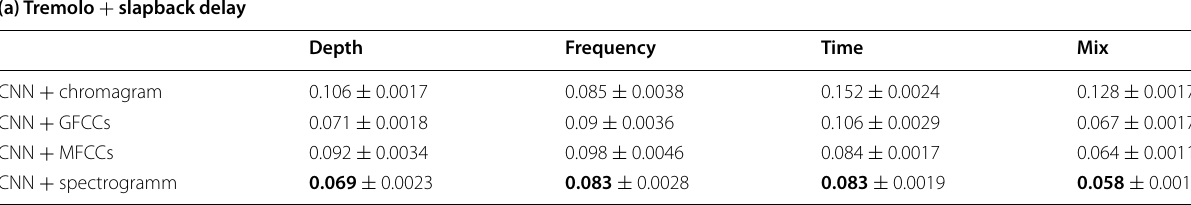
Table 7 95% confidence intervals of the mean absolute error of the CNN across the fivefold cross-validation of the parameter extraction and all volumes. Results are reported for all time-frequency representations and the combination of tremolo and slapback